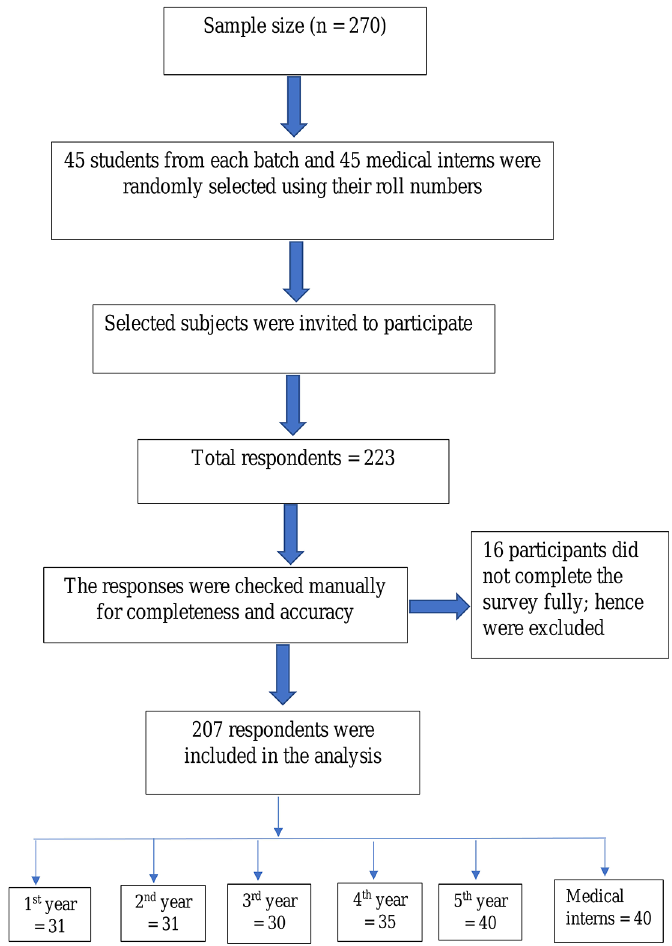
Figure 1. Flow chart of the participants ’ inclusion for